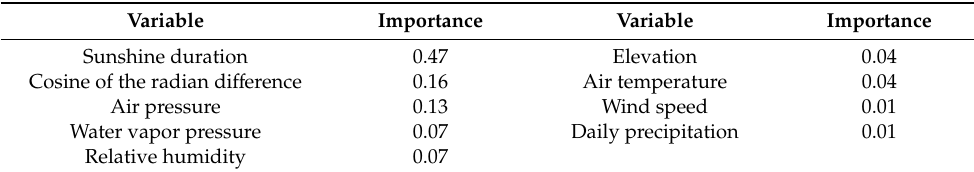
Table 3. Variable importance measure.